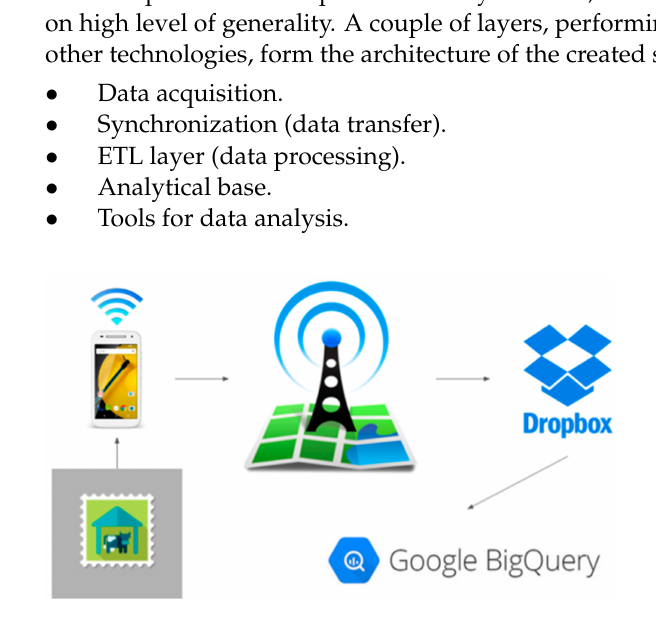
Figure 4. The concept of the created